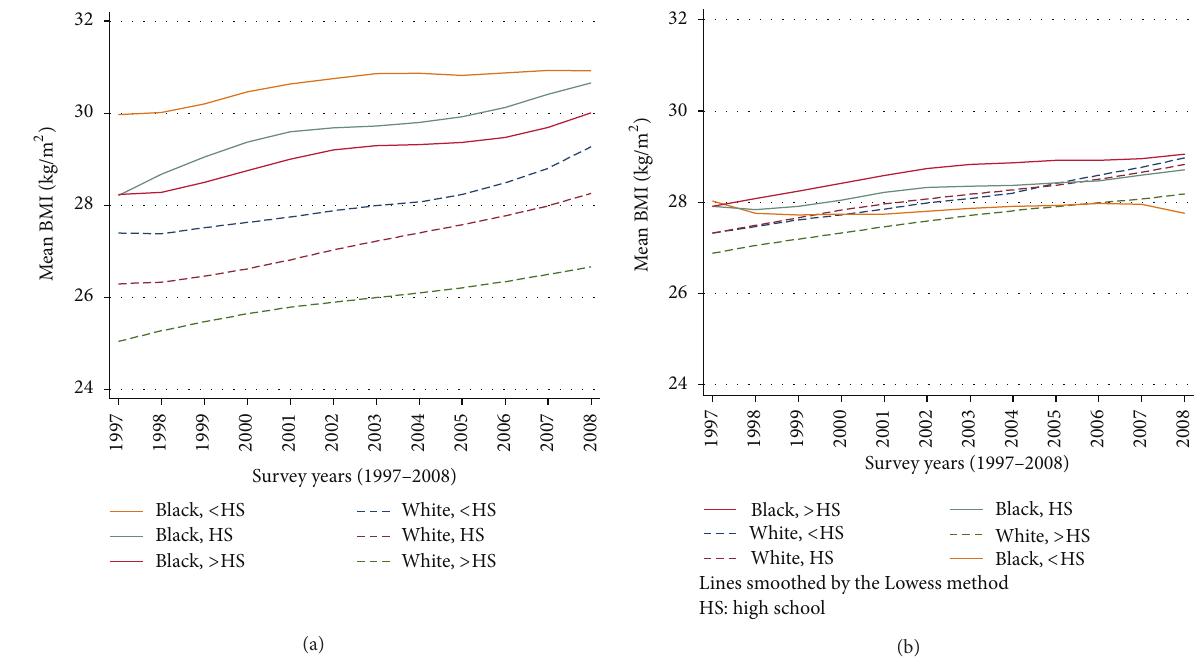
Figure 2: Smoothed trends in mean body mass index among (a) women and (b)